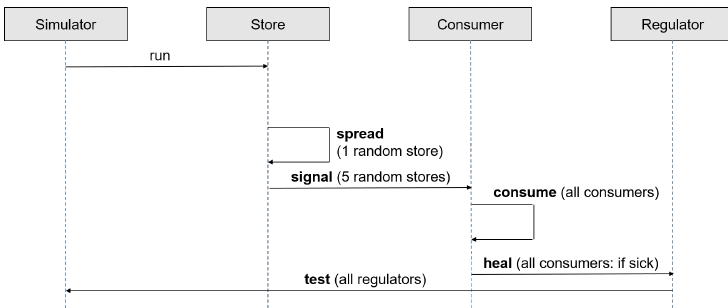
Figure 8. Sequence Diagram of Simulation Flow for the Knowles model [5].